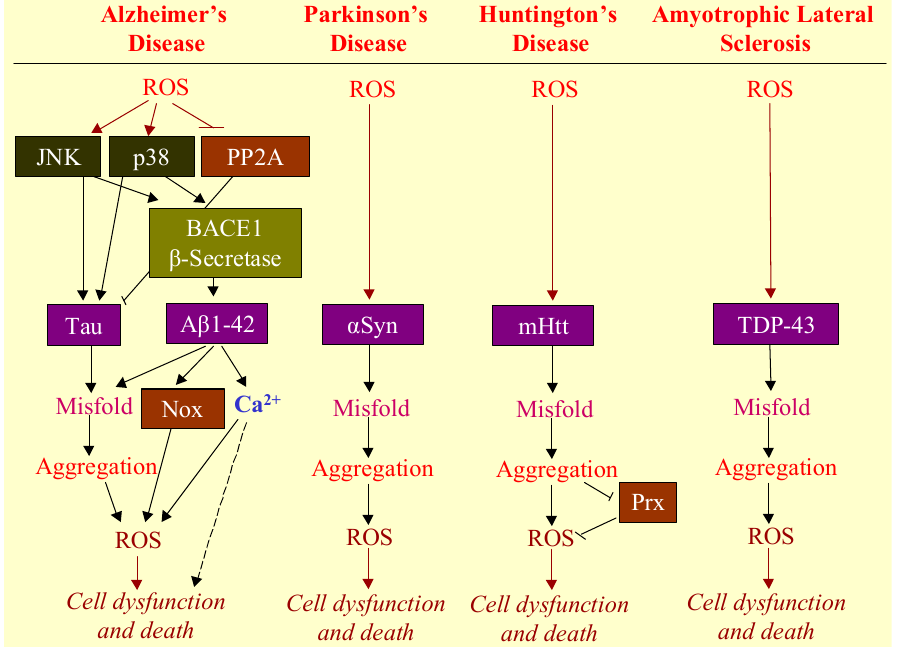
Figure 3. The causal relationship between ROS and misfolded proteins underlying neurodegenerative diseases. A common feature in neurodegenerative diseases is the existence of hallmark protein(s) for each, such as Tau and beta-amyloid (A β ) for Alzheimer’s disease (AD), alpha-synuclein ( α Syn) for Parkinson’s disease, mutant huntingtin protein (mHtt) for Huntington’s disease, and TAR DNA binding protein (TDP-43) for Amyotrophic lateral sclerosis. ROS mediate neurotoxicity in each of these diseases through modifying the hallmark protein by oxidation. In AD, ROS could also activate c-Jun N -terminal kinases (JNK) and p38, and deactivate protein phosphatase 2A (PP2A). JNK and p38 promote the expression of Tau, which is inhibited by PP2A. The activation of JNK and p38 further stimulate A β PP cleaving enzyme 1 (BACE1), causing A β 1-42 accumulation, which leads to activation of NADPH oxidase (Nox) to